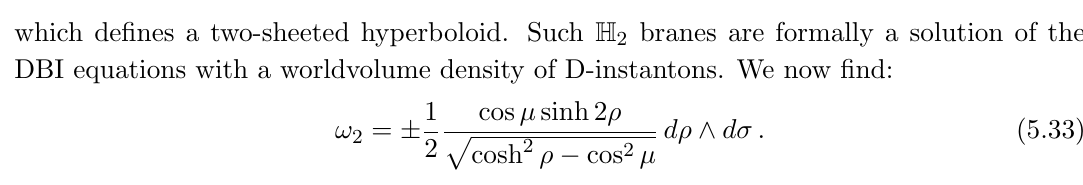
2 and dS 2 branes